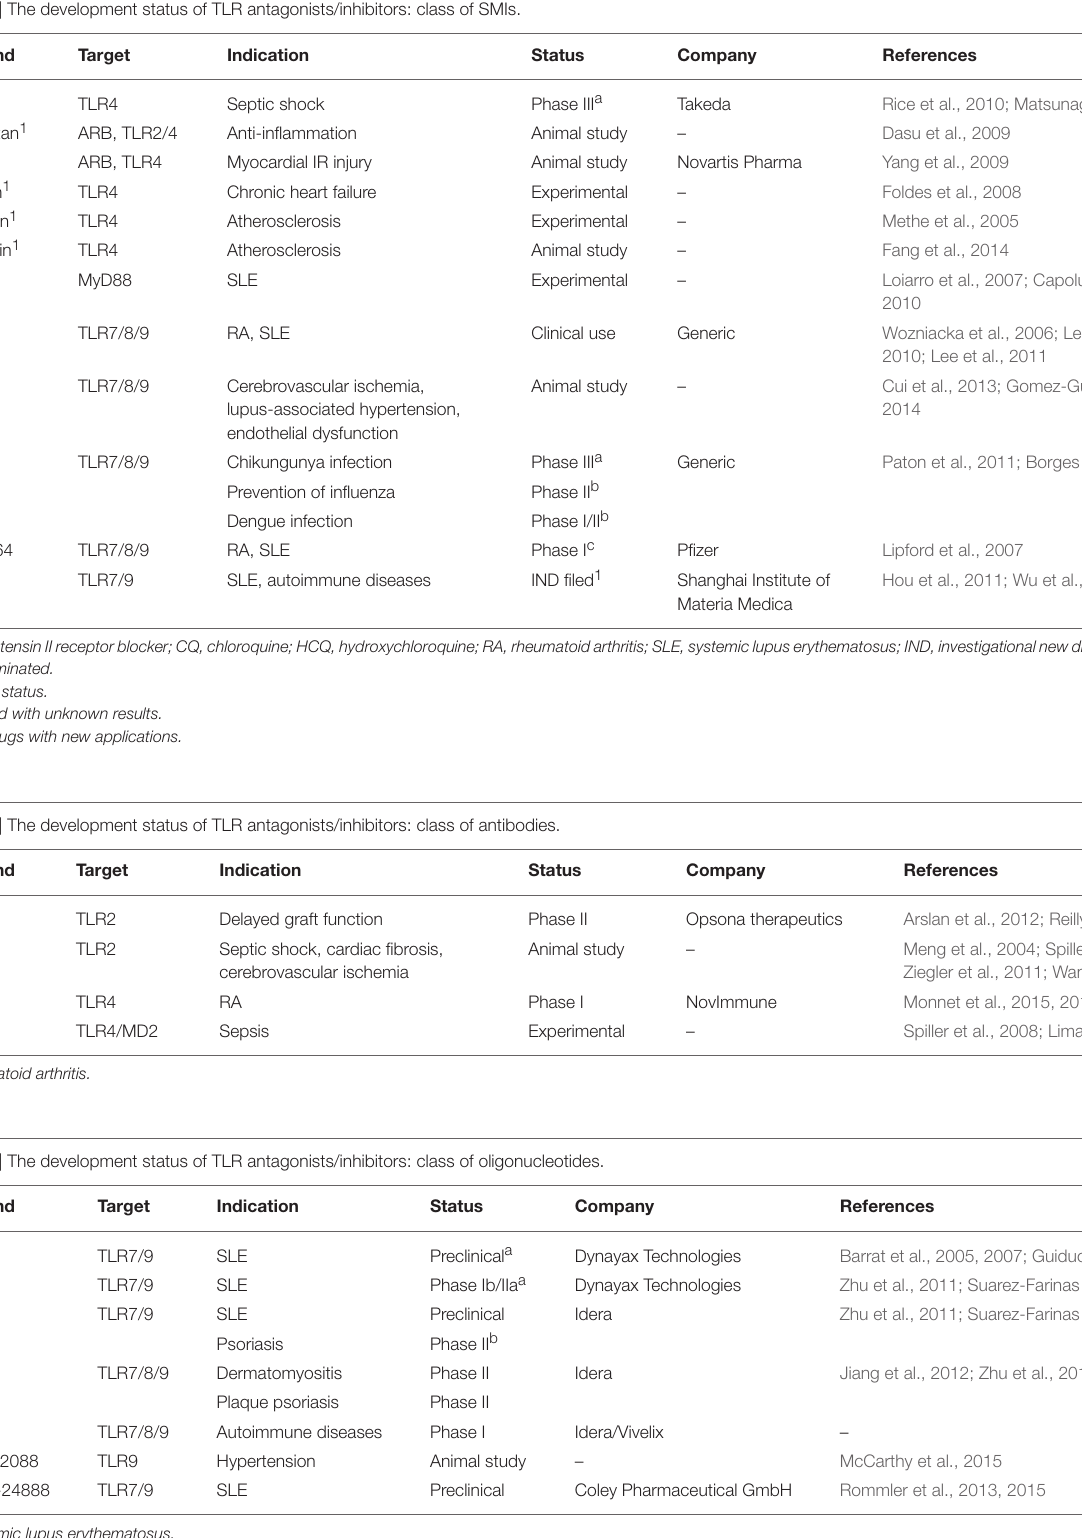
TABLE 2 | The development status of TLR antagonists/inhibitors: class of SMIs. Compound